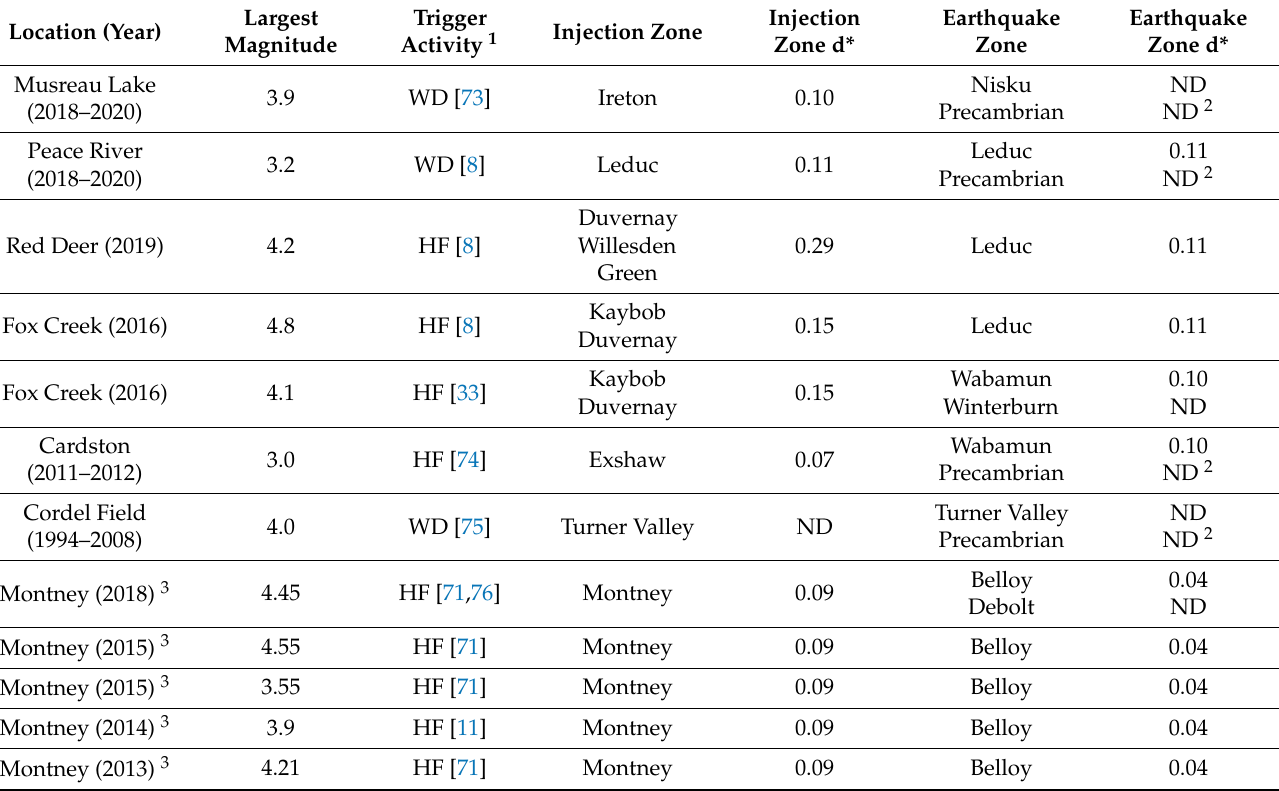
Table 5. Summary of recent significant induced earthquake sequences in Alberta and British Columbia.